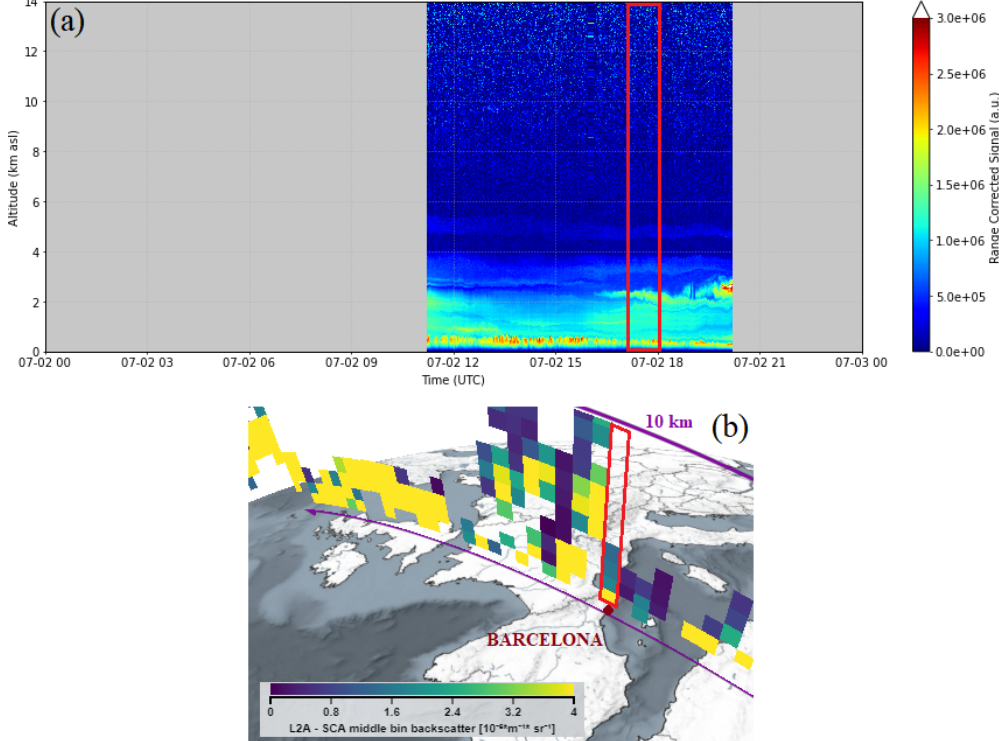
Figure 10. (a) Lidar range-corrected signal measured with the 1064nm channel in Barcelona on 2 July 2019. (b) Aeolus SCAmb backscatter retrievals along the considered orbit (4976), with the profile closest to the station marked in red (source: VirES for Aeolus, https://aeolus. services/, last access: 7 January 2022). Quality flags are